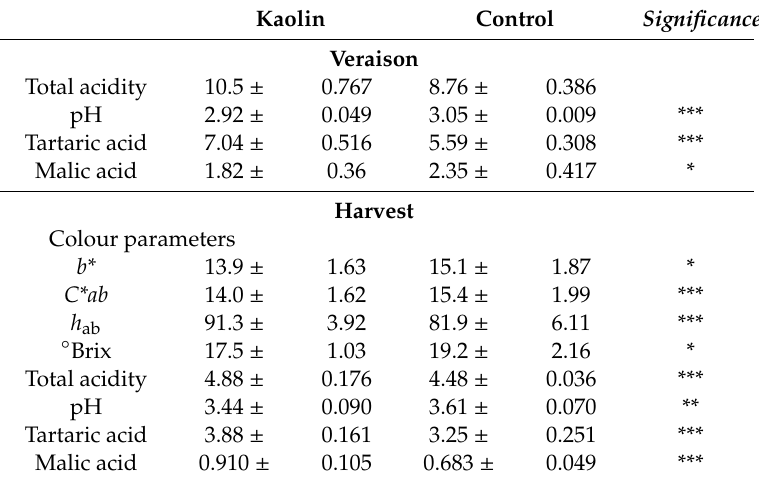
Table 3. Kaolin e ff ect on colorimetric parameters analyzed for all grape skin color variants and ◦ Brix of fruits picked in the maturation period, and total acidity (g L − 1 of tartaric acid), pH, tartaric and malic acid concentration (g L − 1 ) of fruits picked in the veraison and maturation stages, in 2017. Values are presented as mean ± SD. Significant di ff erences were presented between treatments and considered for p < 0.05 and *** p < 0.001, ** p < 0.01, * p < 0.05 represent significant di ff erences; ns indicates no significant di ff erences. Kaolin Control Significance Veraison Total